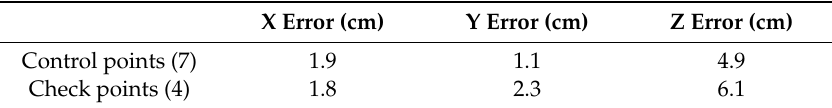
Table 3. Control and check points root mean square errors (RMSE).